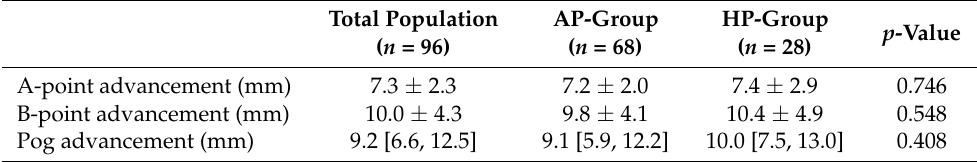
Table 2. Surgical characteristics of the total population, AP-group and HP-group. Total Population